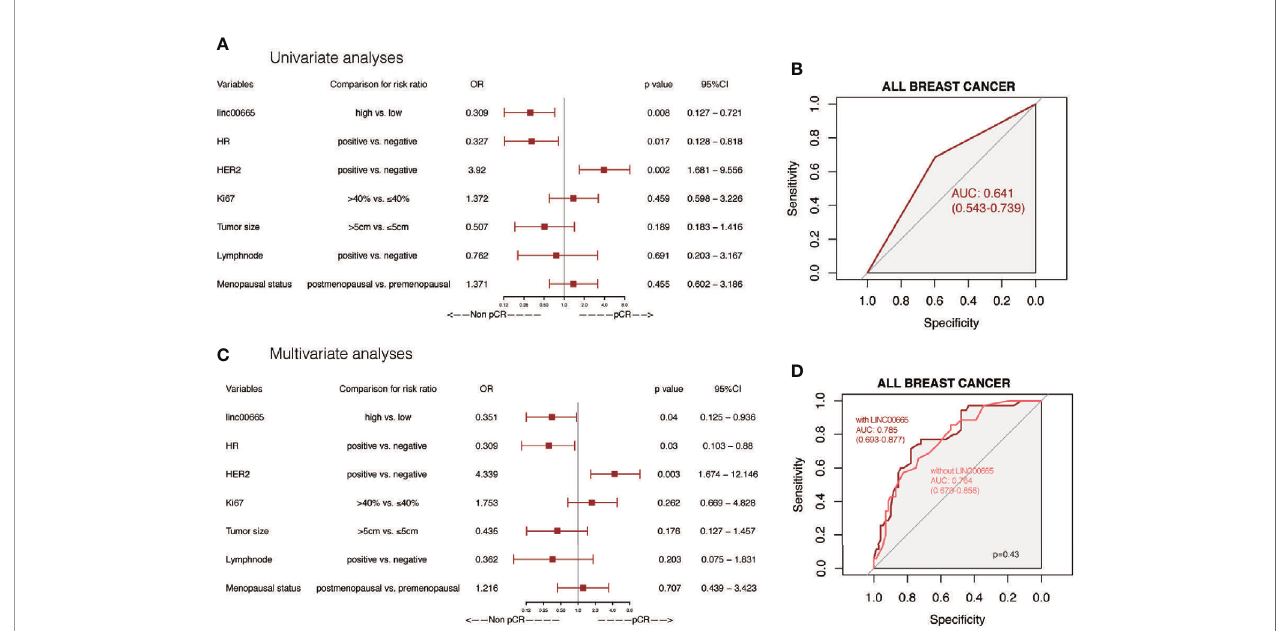
FIGURE 1 | The predictive value of Linc00665 expression in NAC pCR in all patients included (A) Univariate logistic regression analysis of potential predictive markers in the whole cohort; (B) Performance of Linc00665 expression in predicting pCR evaluated by ROC in the whole cohort; (C) Multivariate logistic regression analysis of potential predictive markers in the whole cohort; (D) ROC of multivariate logistics regression including clinicopathological factors with or without Linc00665 expression in the whole